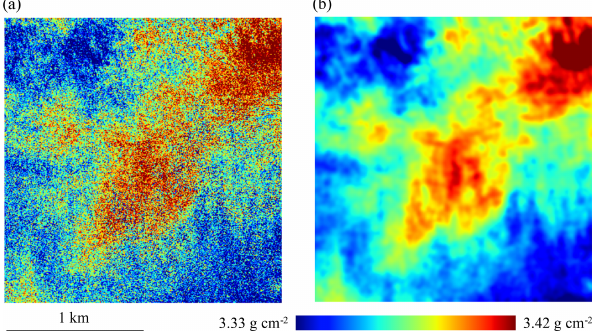
Figure 9. (a) Initial water vapor map from flight line C. (b) Noise reduction after kernel smoothing reveals fine-scale structure at sub- kilometer scales.